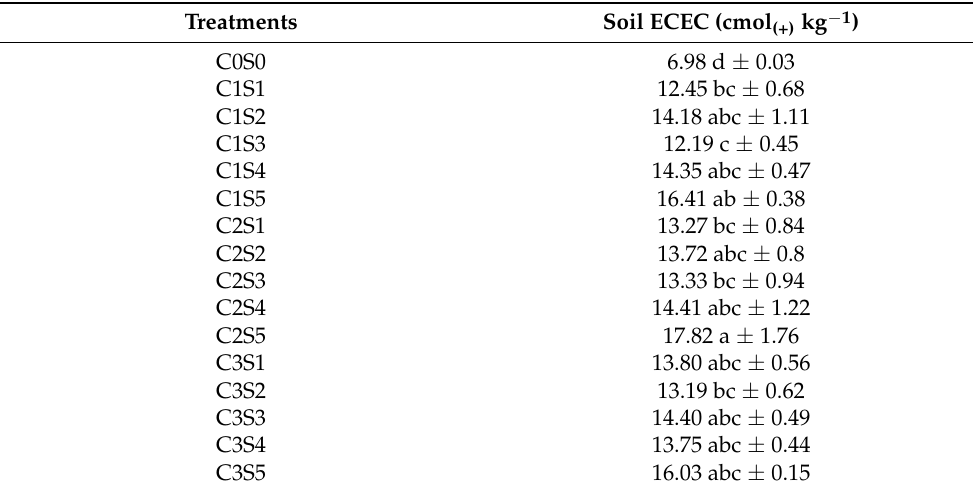
Table 6. Mean soil effective cation exchange capacity for the different treatments after thirty days of